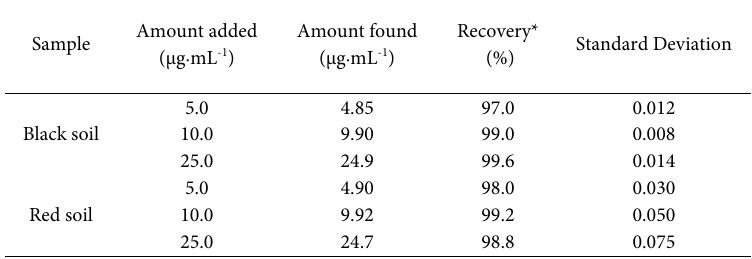
Table 1. Application of the recommended method to the determination of butachlor in soil samples